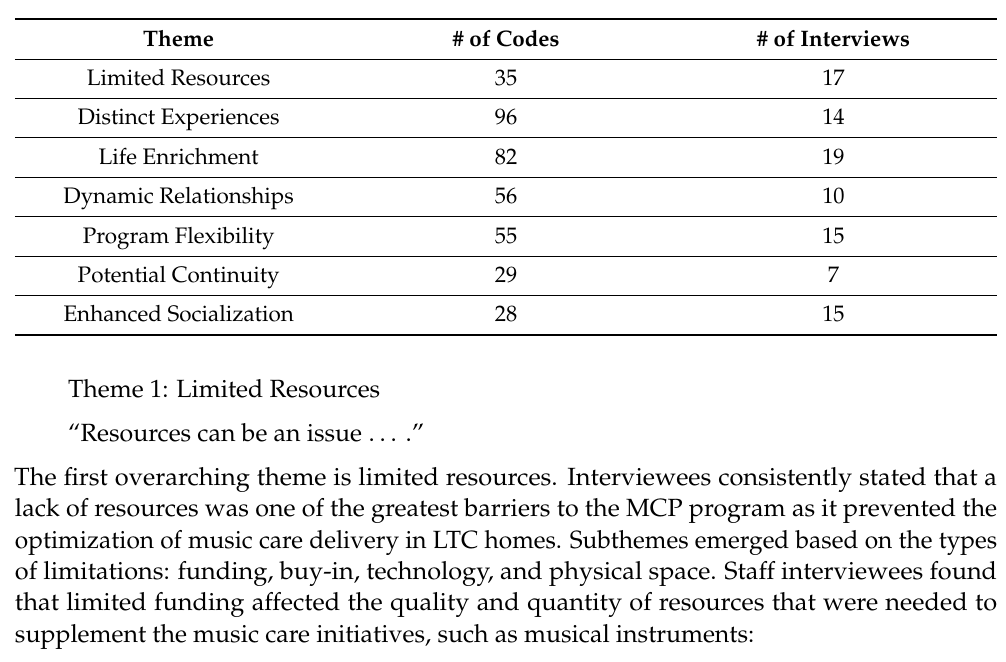
Table 4. Theme names, number of contributing codes, number of interview